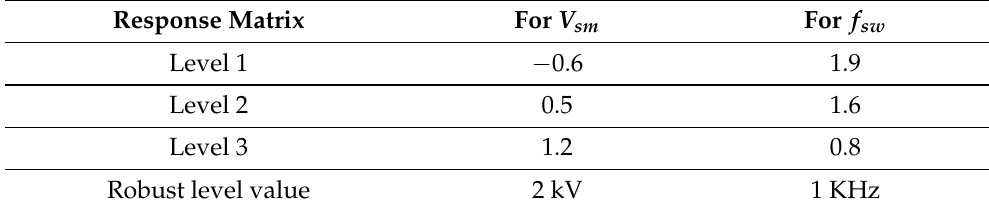
Table 4. Response matrix for MMC to minimize failure